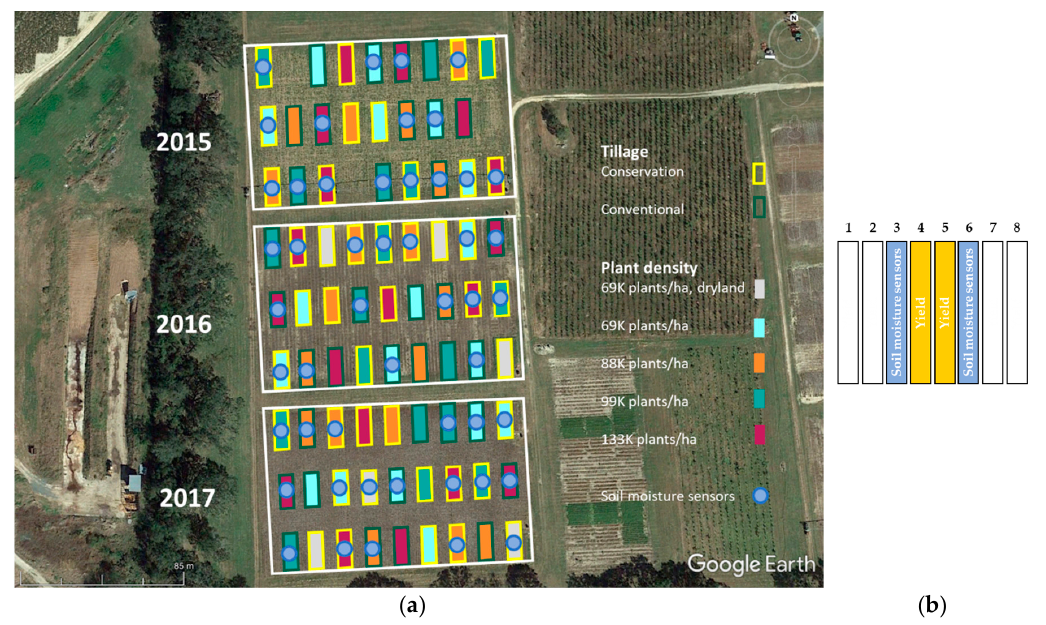
Figure 3. ( a ) Plot plans of maize during 2015, 2016, and 2017 growing seasons in SIRP field and ( b ) plots configuration.